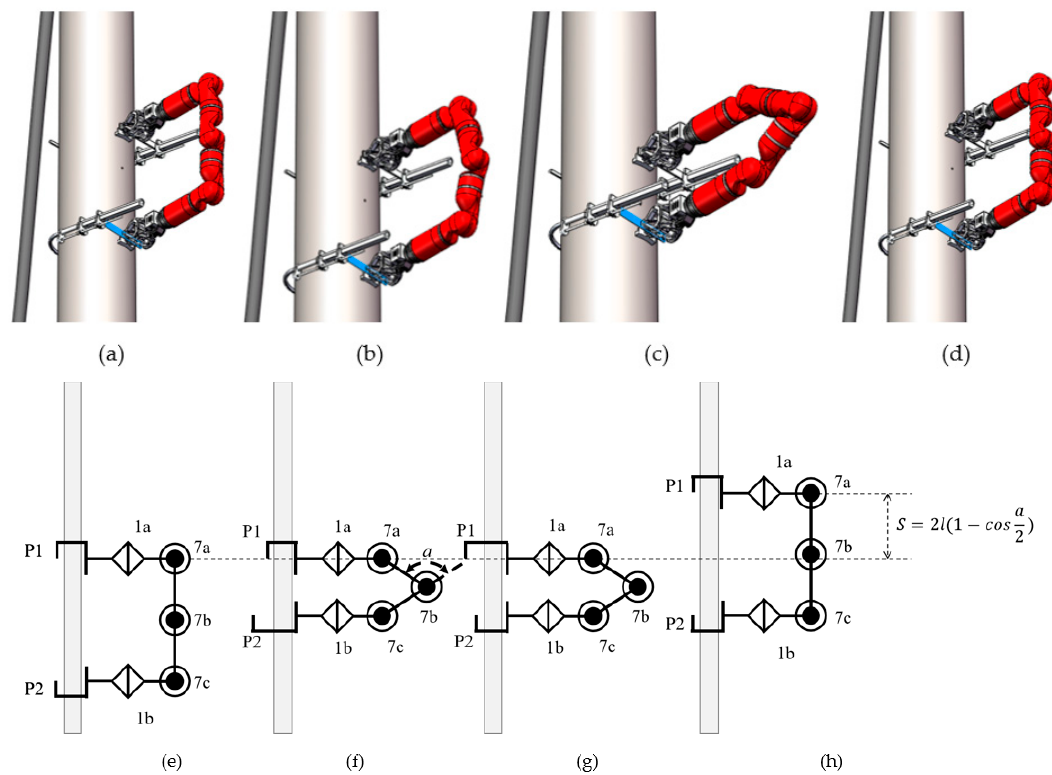
Figure 10. Inchworm gait. ( a ) Initial state, ( b ) motion 1, ( c ) motion 2, ( d ) completed state, ( e ) front elevation of initial motion, ( f ) front elevation of motion 1, ( g ) front elevation of motion 2, ( h ) front elevation of completed state